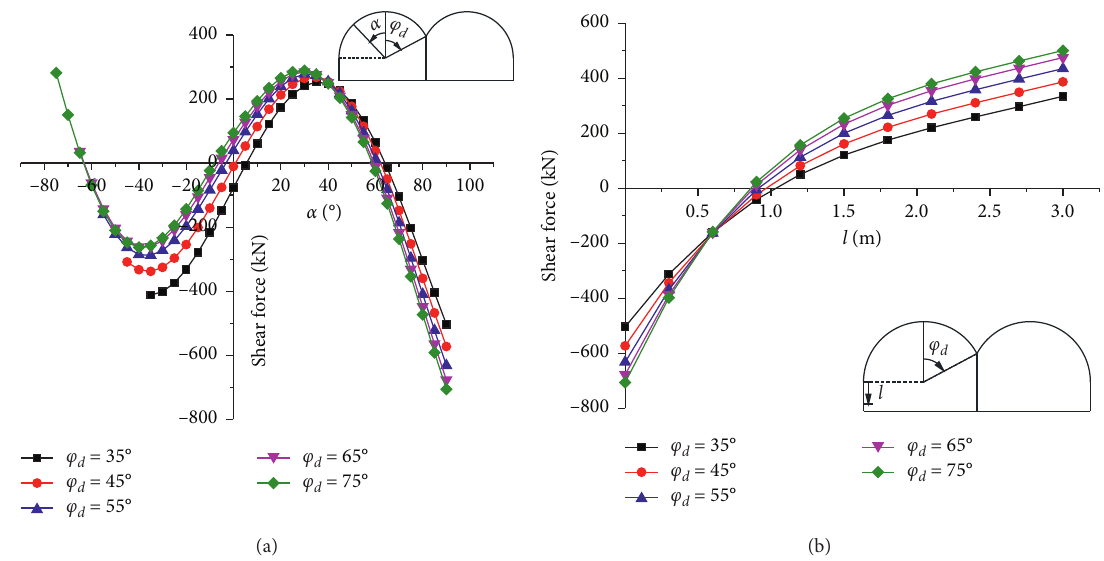
Figure 20: Variations of shear force with φ d : (a) along the arch ring; (b) along the side wall.